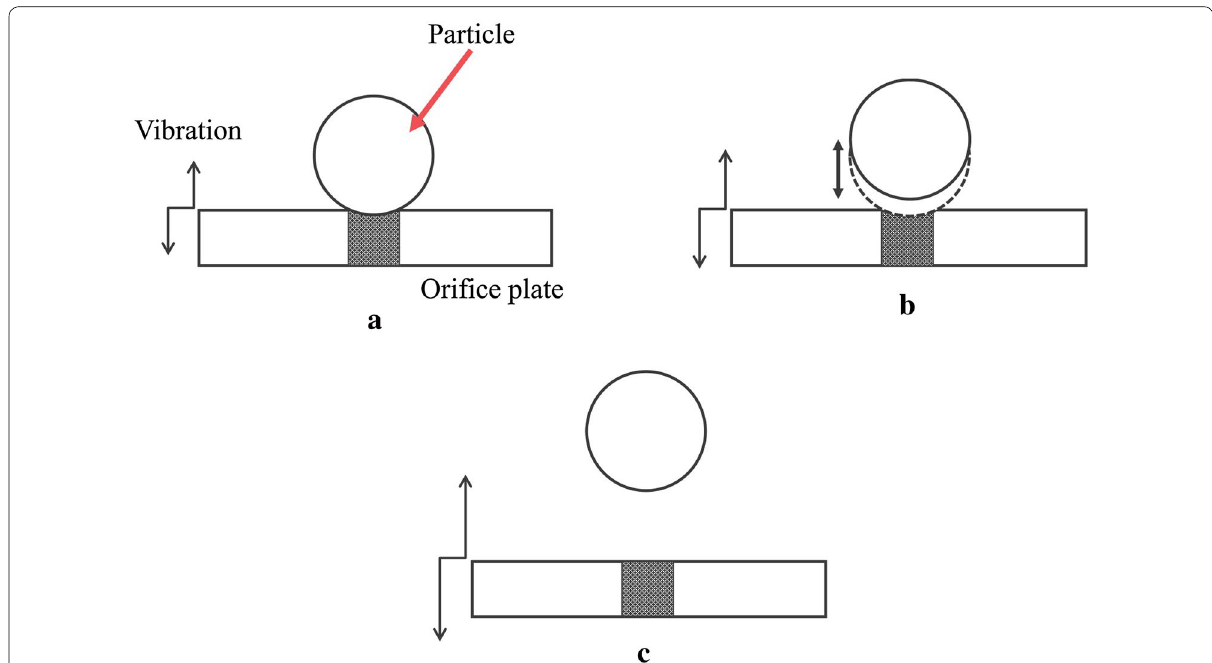
Fig. 17 Image of particle movement ( a – c )